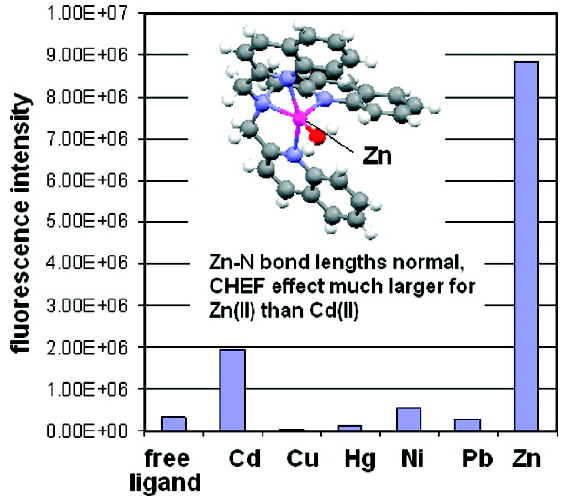
Figure 11. In the Zn 2+ -TQA complex, the ligand is not overcrowded and the Zn-N bond lengths are not distorted. Therefore, the CHEF effect induced by Zn 2+ is stronger that induced by bigger ions. Reprinted with permission from Reference [33]. Copyright (2009) American Chemical Society.